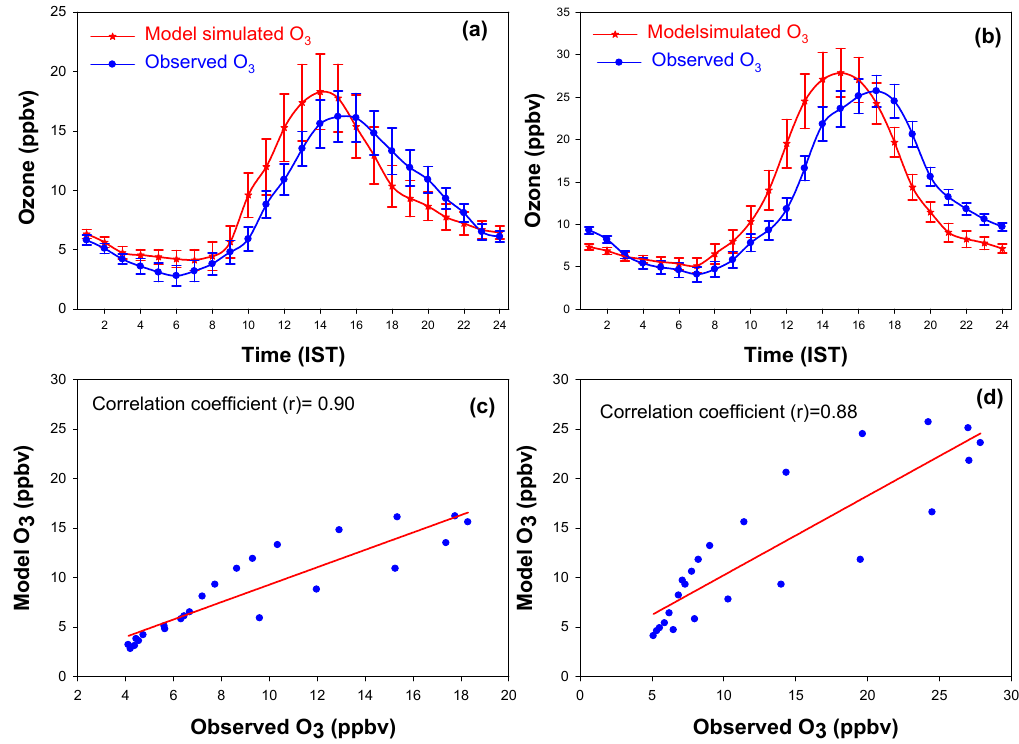
Figure 9. Diurnal variation of measured (averaged over the period 2013–2018) and modeled O 3 for ( a ) monsoon, ( b ) post monsoon, and ( c ) scatter plot showing the correlation between model O 3 and measured O 3 for monsoon, ( d ) post monsoon.